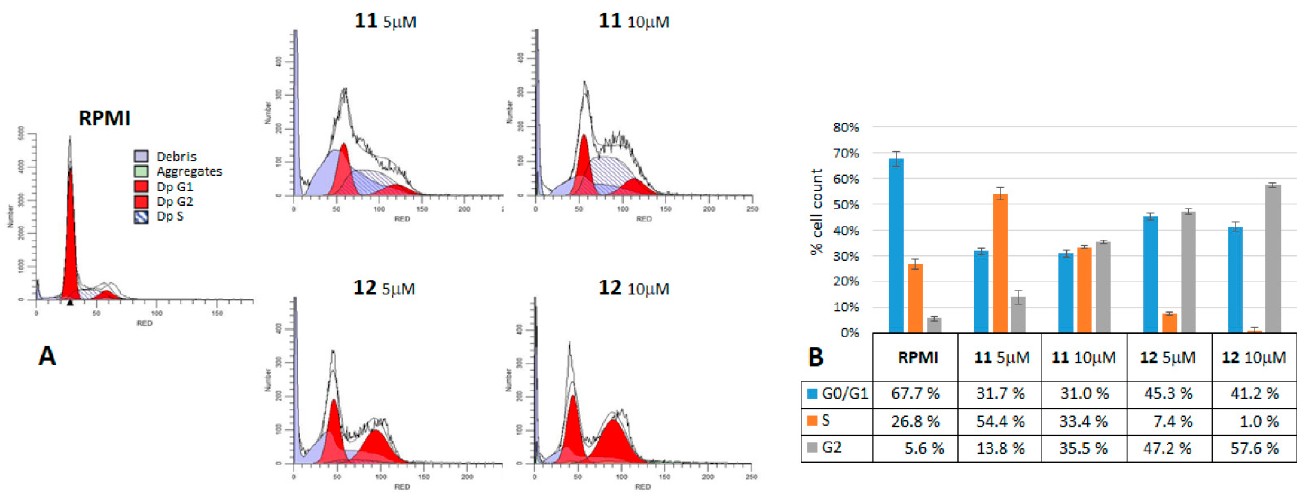
Figure 8 . Cell cycle arrest. A375 MM cells were treated with 5 and 10 μ M 11 and 12 , for 24 h and then analyzed by Tali ® Cell Cycle assays. ( A ) The results were analyzed with ModFit ® software [37], and the extrapolated cytograms were reported as exemplificative of a single experiment. ( B ) Histograms represent the percentage of cells in each G0/G1, S, and G2 phase as the mean values of three experiments ± standard deviation.